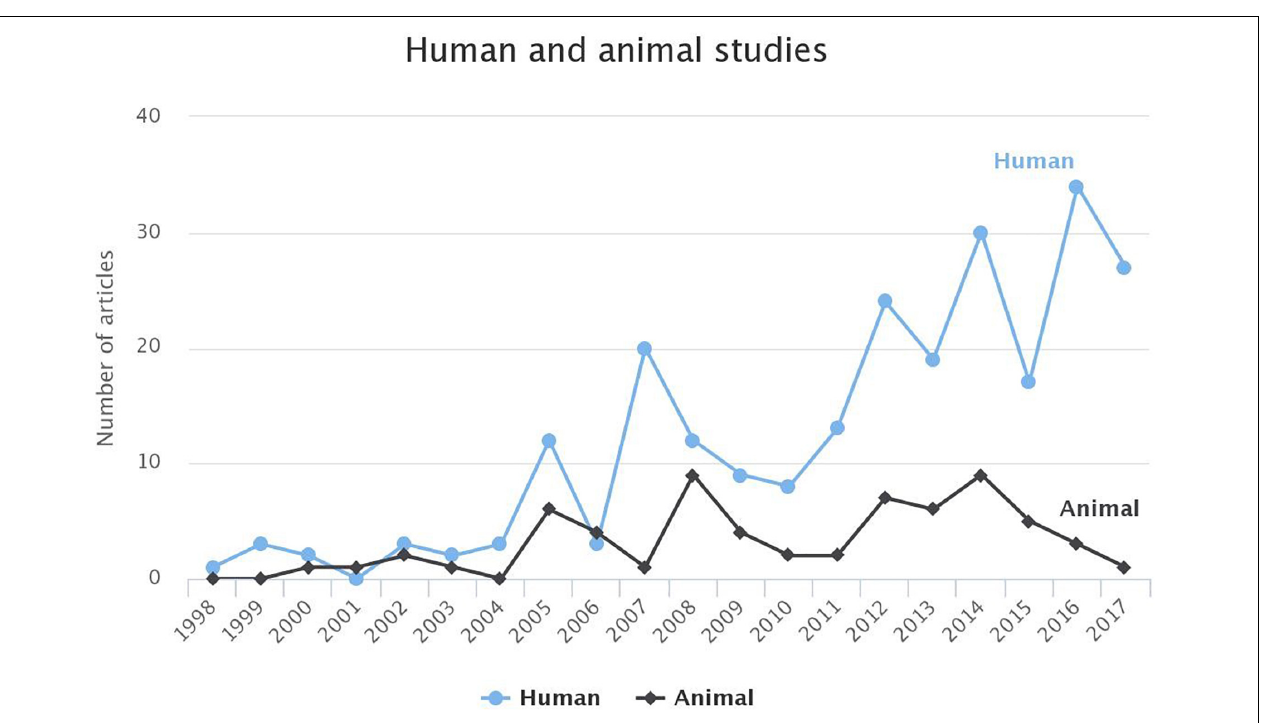
Frontiers in Physiology |